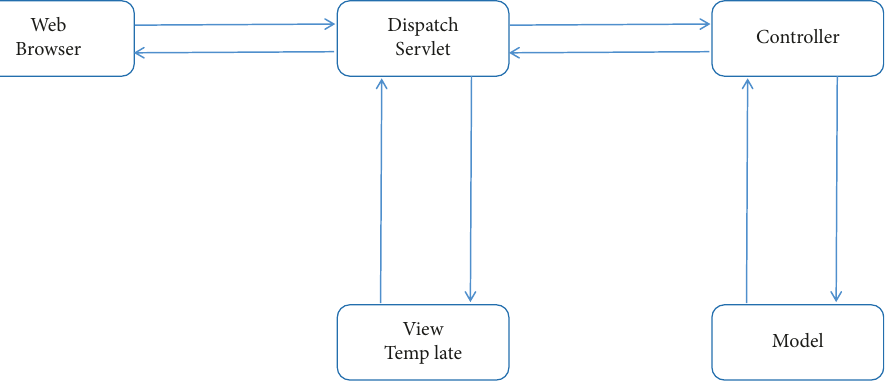
Figure 9: Motion eccentricity.